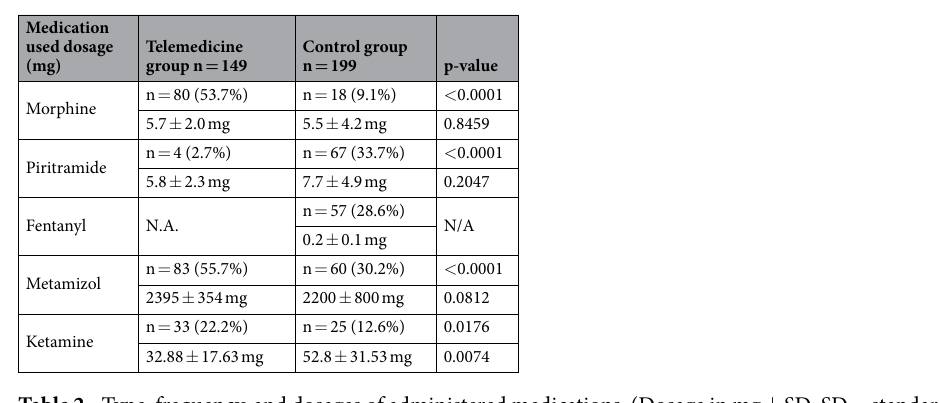
Table 2. Type, frequency, and dosages of administered medications. (Dosage in mg ± SD; SD = standard